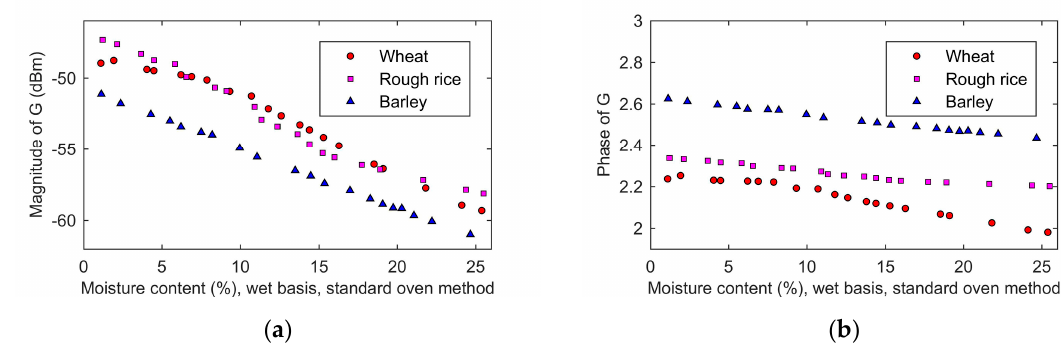
Figure 16. The moisture content dependence of the reflected signal: ( a ) magnitude; ( b ) phase.